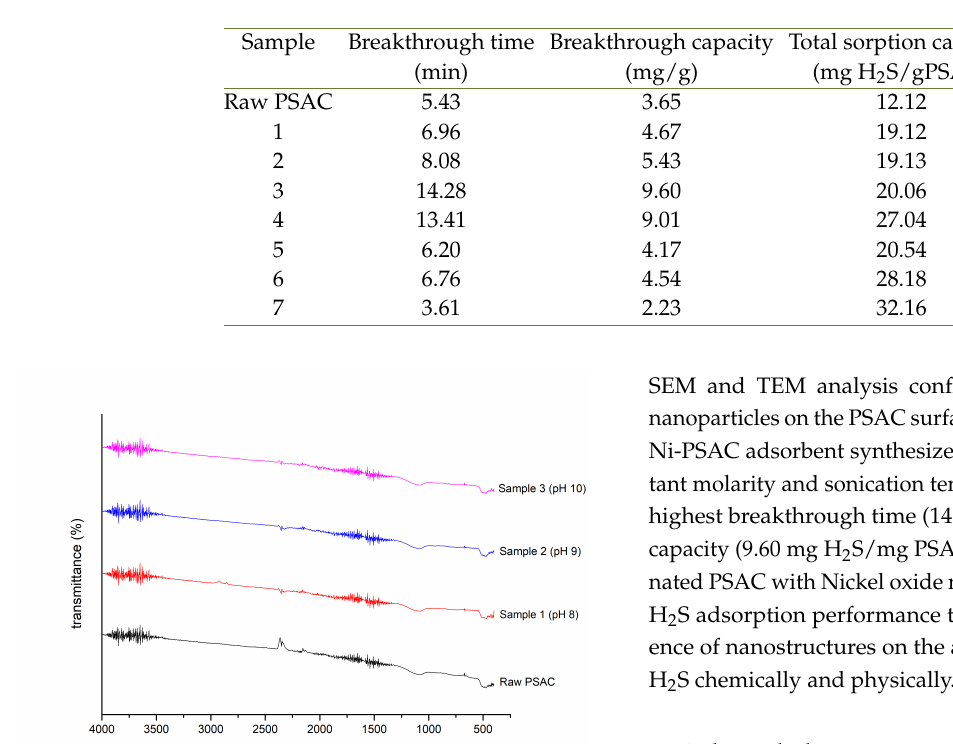
Table 2. H 2 S adsorption performance of raw PSAC and Ni-PSAC adsorbents.